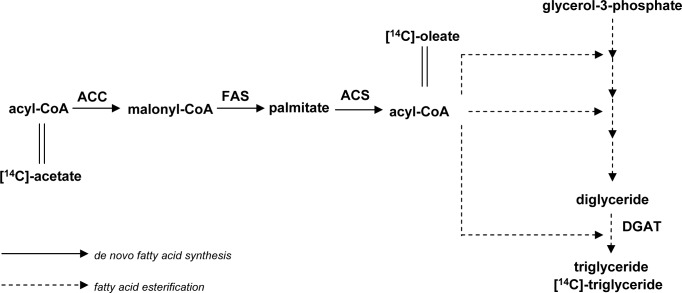
Incorporation of [14C]-acetate and [14C]-oleate in the biosynthetic pathway of triglycerides.